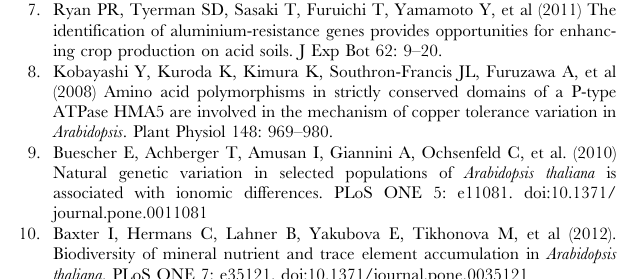
Figure S9 Fe and Zn homeostasis in NILs and parental lines. Fe (A) and Zn (B, C) root contents. Plants were grown on agar plates under control conditions (A, B) or under 200 m M Zn for 10 days before roots were harvested and the Fe and Zn content estimated. Measurements were performed on sets of 5 to 20 plants. Values are the mean 6 S.D.M. where n= 4. Figure S10 Localization of Fe in roots. Fe accumulation is visualized by Perls staining [21] of intact roots of plants grown on compost for 3 weeks. Only frd3-7 plants accumulate Fe in the xylem. Scale bar, 50 m m. Figure S11 AtFRO2 transcript levels. AtFRO2 ( FERRIC REDUC- TION OXIDASE 2 ) is an Fe deficiency marker. Its transcript levels were determined under Fe deficient (Fe0), control (Zn1) and excess Zn (Zn150) conditions in Bay-0 and Shahdara parental lines and in NILs. FRO2 transcript levels are expressed relative to the transcript level of actin (ACT2/ACT8). Values are the means 6 S.D.M. where n= 3 independent experiments. Figure S12 Root ferric chelate reductase activity. Plants were grown on control medium for 7 days and transferred to either iron deficient ( 2 Fe) or iron sufficient ( + Fe) medium 4 days before the assay. Values are the mean 6 S.D.M. where n= 3 sets of 3 plants. With the exception of frd3-7 , all genotypes present a significantly different level of root ferric chelate reductase activity in roots subject to iron deficiency than is found in iron-sufficient treatments ( P , 0.05, Student test). Figure S13 Citrate content of xylem exudates. Plants were grown in a growth chamber for 6 weeks and xylem exudates were collected during 2 h after removing aerial parts of the plant at the hypocotyl. Values are means 6 S.E.M. where n= 8 to 12. Different letters above bars refer to significantly different values at P , 0.05 according to a nonparametric test. Table S1 QTL analyses. (a) Relative variation of the Primary Root length between 150 m M Zn and control condition (RelPR 150 ). (b) The position of the QTL is expressed in cM from the 1st marker of the chromosome. (c) Name of the closest marker,